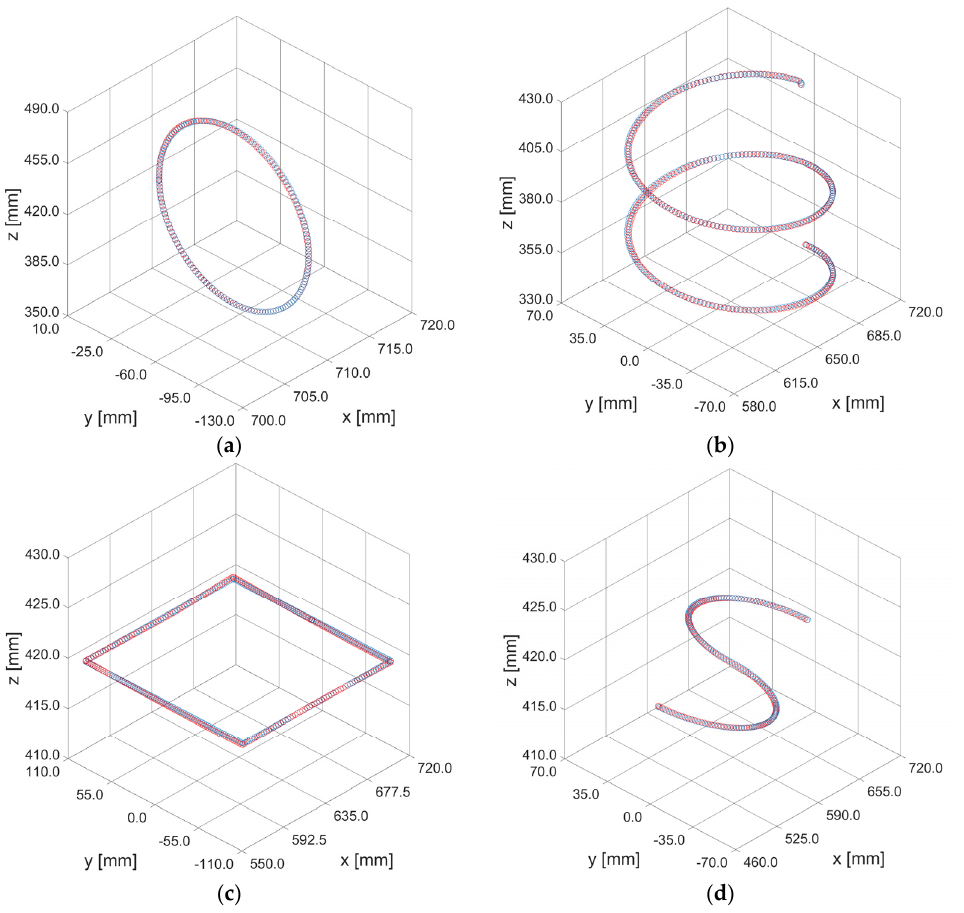
Figure 6. Robot (blue) vs. IK procedure (red) for the implemented trajectories: ( a ) circle in the Y-Z plane; ( b ) spiral X-Y along Z-axis; ( c ) rectangle in the X-Y plane ( d ) S-shape in the X-Y plane.